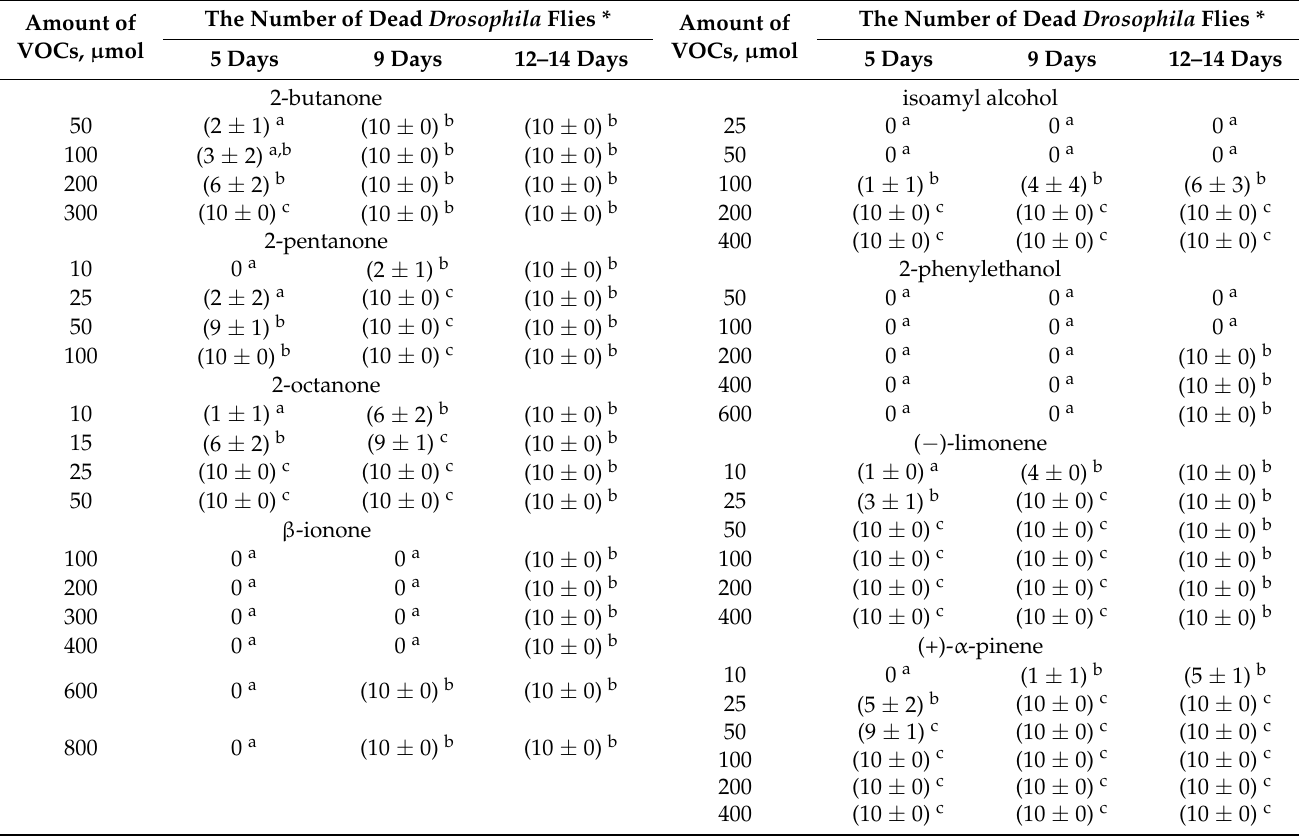
Table 4. Effect of VOCs on Drosophila melanogaster